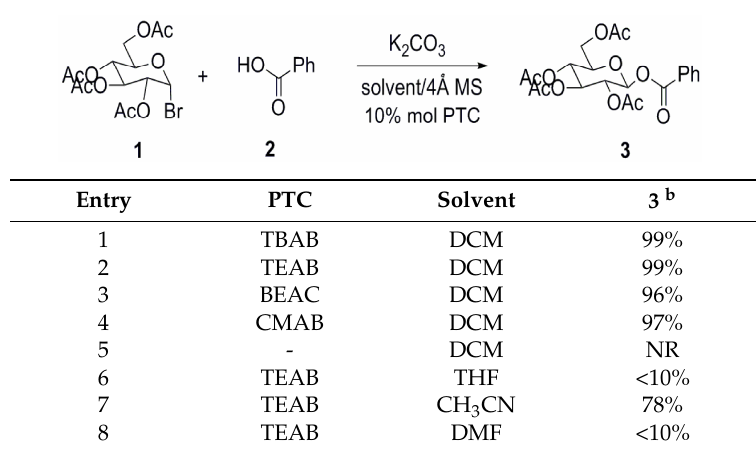
Table 2. Variation of PTC and the solvent a .